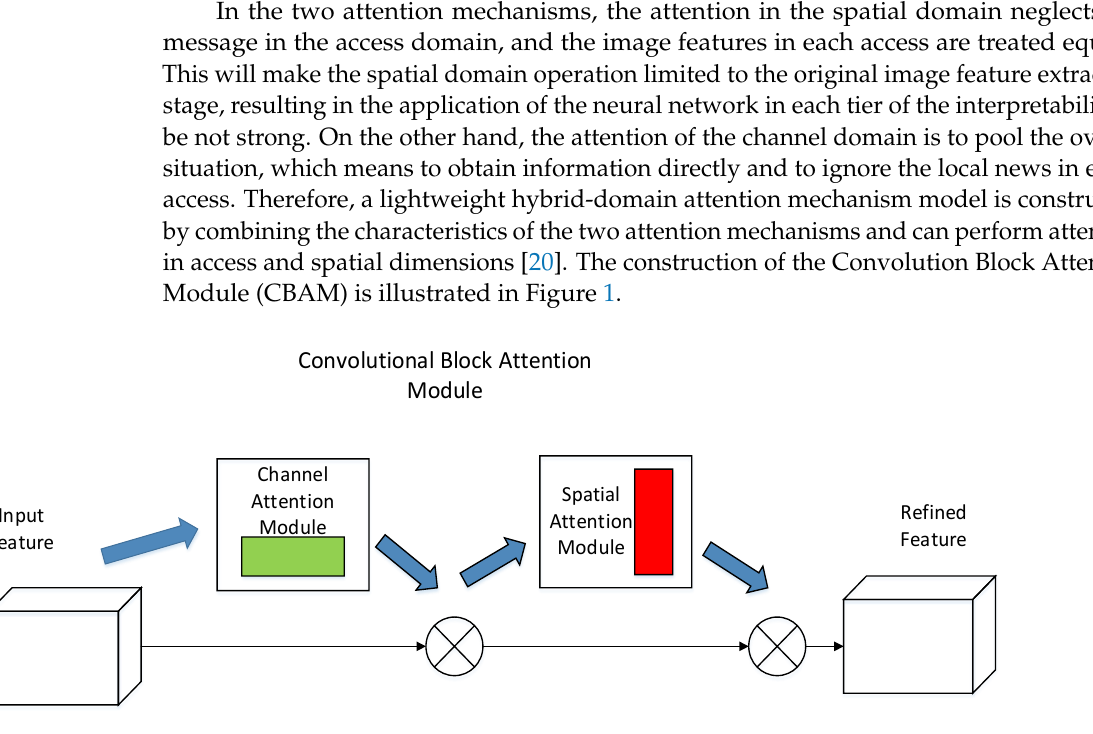
Figure 1. CBAM construction diagram with the hybrid attention mechanism module.